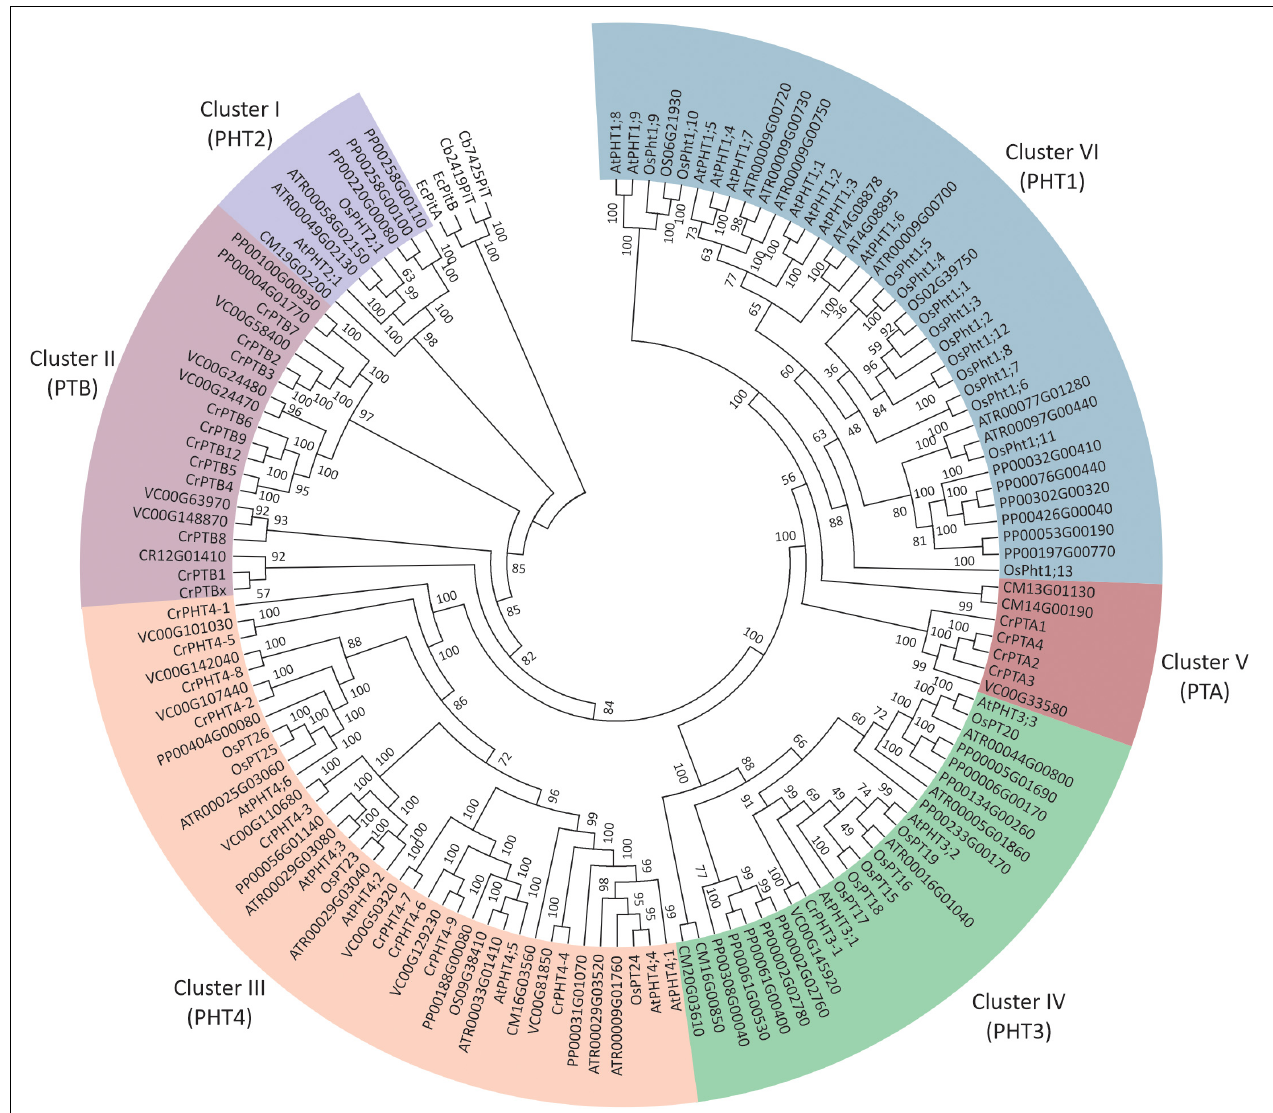
FIGURE 1 | Phylogenetic analyses of phosphate transporter genes in Arabidopsis thaliana (At), Oryza sativa (Os), Amborella trichopod a (Atr), and Volvox carteri (Vc). Physcomitrella patens (Pp) and Chlamydomonas reinhardtii (Cr). Four PHT genes from Escherichia coli and Cyanobacteria were selected as outgroup. Multi-sequence alignments were performed by Clustal Omega, and a phylogenetic tree was reconstructed by IQTREE using the maximum likelihood method. WAG + F + R6 was the best-fitting evolutionary model selected by ModelFinder under Bayesian Information